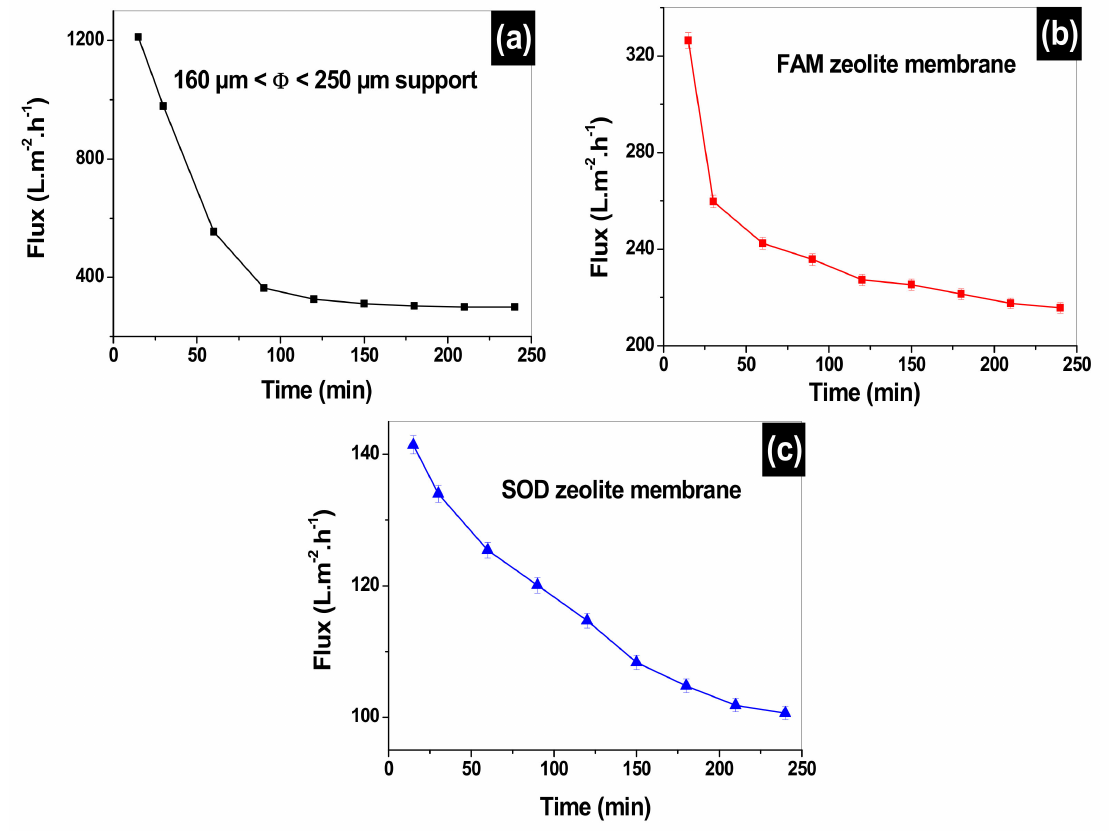
Figure 9. MO flux variation versus filtration time for: the 160 µ m ≤ Φ ≤ 250 µ m support ( a ), faujasite (FAM) ( b ) and sodalite (SOM) ( c ) composite zeolite/clay